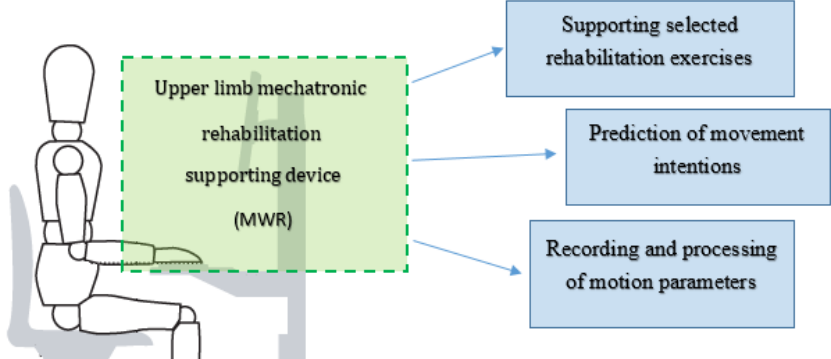
Figure 4. General concept of the novel mechatronic system supporting the rehabilitation of upper limbs.